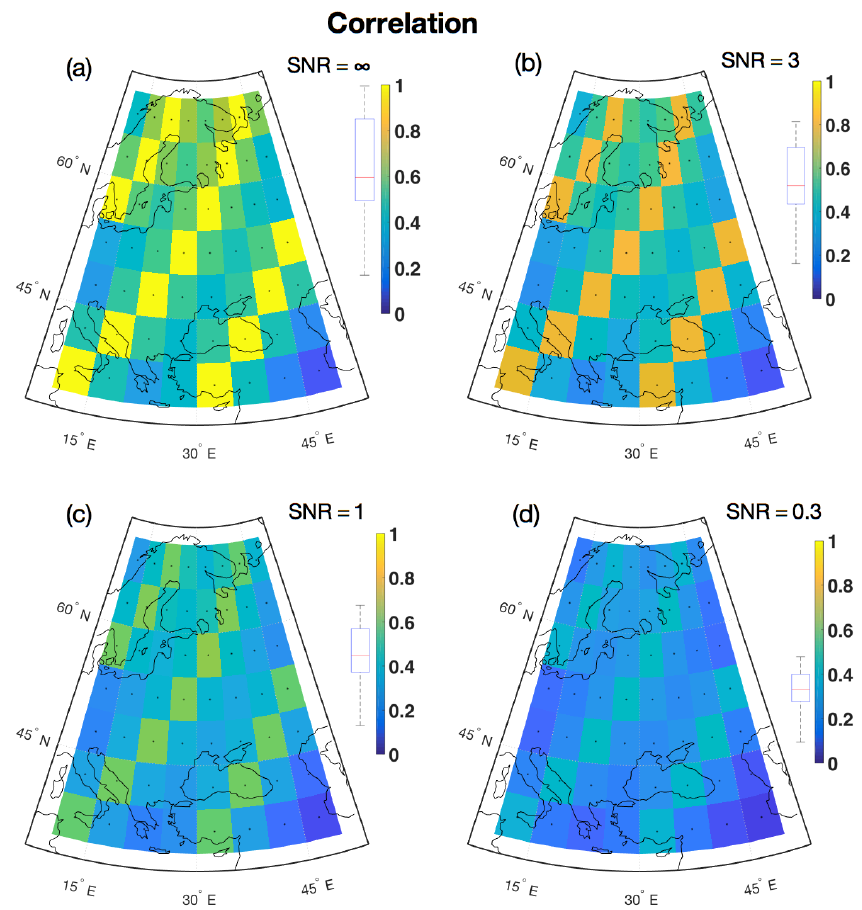
Figure 7. Local correlation coefficient between reconstructed temperature field and target field for the verification period (ensemble mean). The box plots left of the color bars indicate the distribution of grid point correlation coefficients. β =